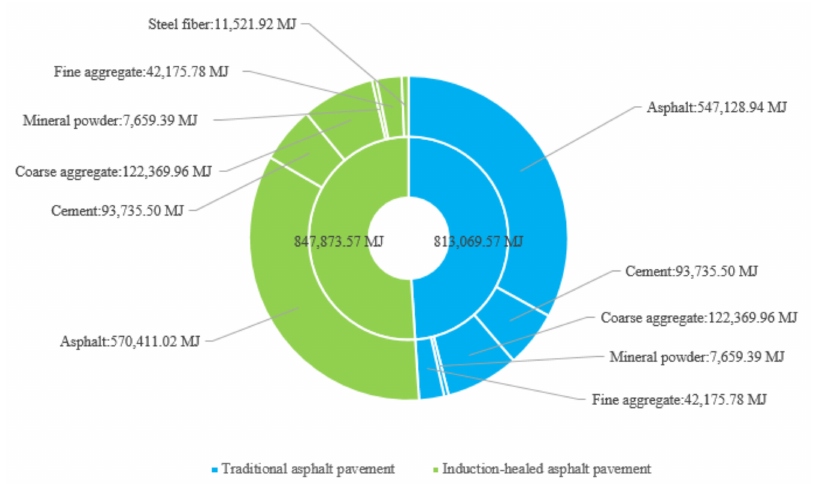
Figure 2. Energy consumption comparison between induction-healed pavement and traditional pavement in the material manufacturing stage.